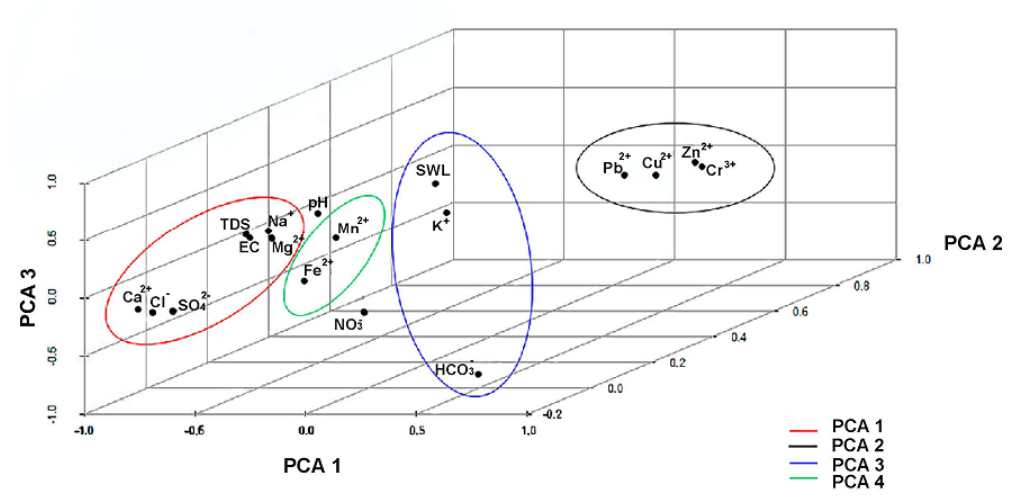
Figure 6. Principal component analysis (PCA) plot of variable space deduced from the geochemical